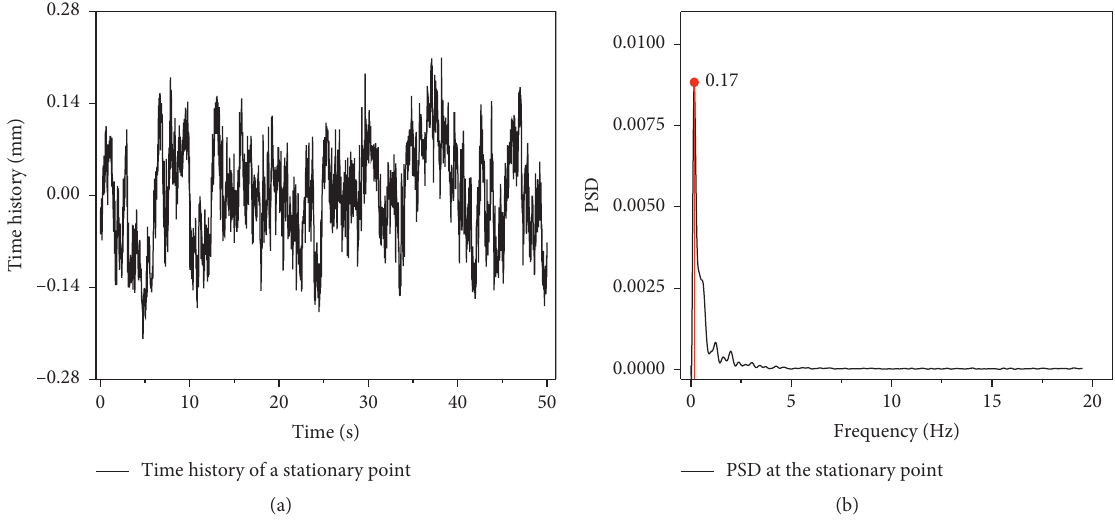
Figure 12: Analysis data of a stationary point by DIC. (a) Time history of a stationary point. (b) PSD at a stationary point.